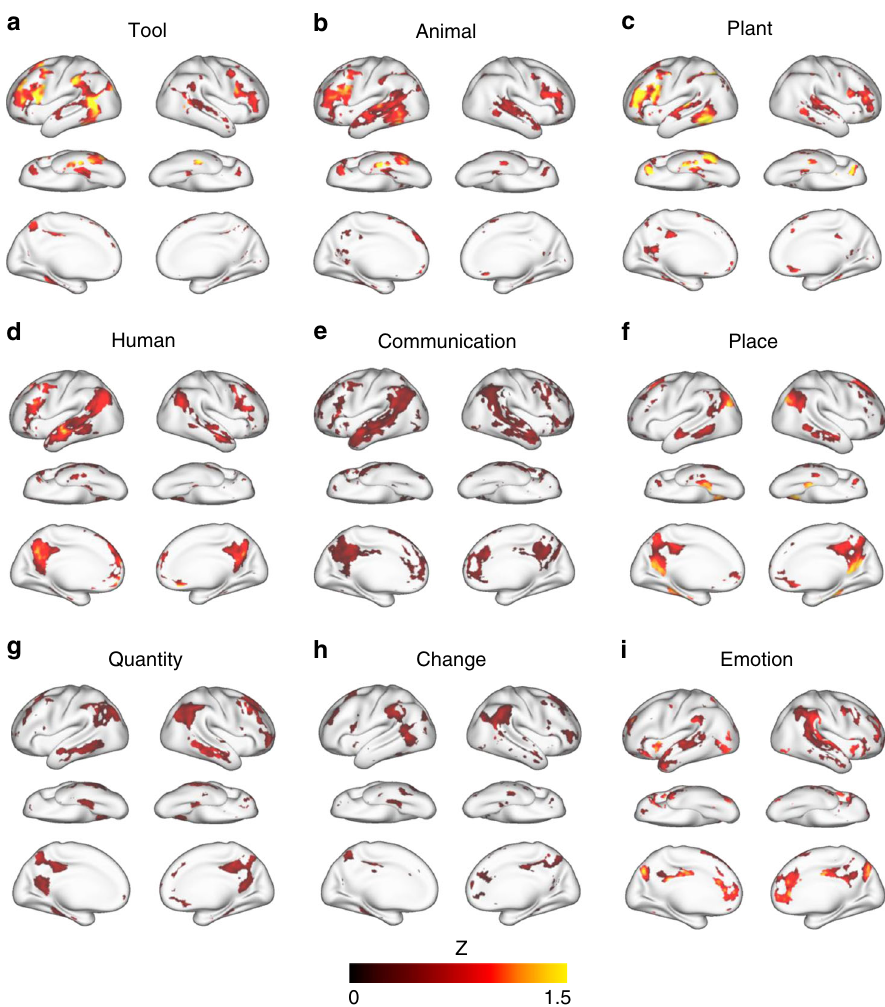
Fig. 4 Cortical representations of semantic categories. For each category, the color indicates the mean of the normalized response (or the z score) averaged across word samples in the category (Supplementary Table 3). The color-highlighted areas include the voxels of statistical signi fi cance (one- sample t -test, one-sided, FDR q < 0 :